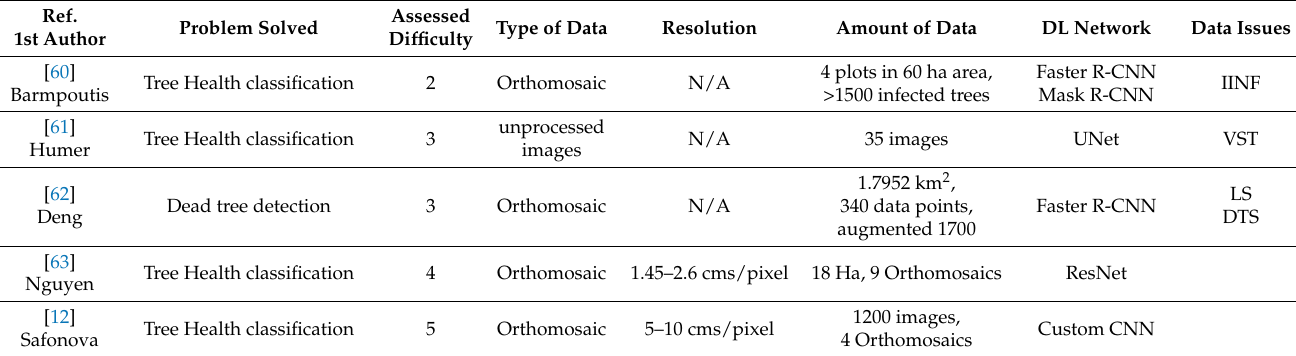
Table 5. Summary of Tree Health related papers reviewed. Regarding the “Data Issues” column, the following notation is used: “Wrong Split” (WS), “Late Split” (LS), “validation set for testing” (VST), “dependent test set” (DTS) or “insufficient information” (IINF), see Section 3 for